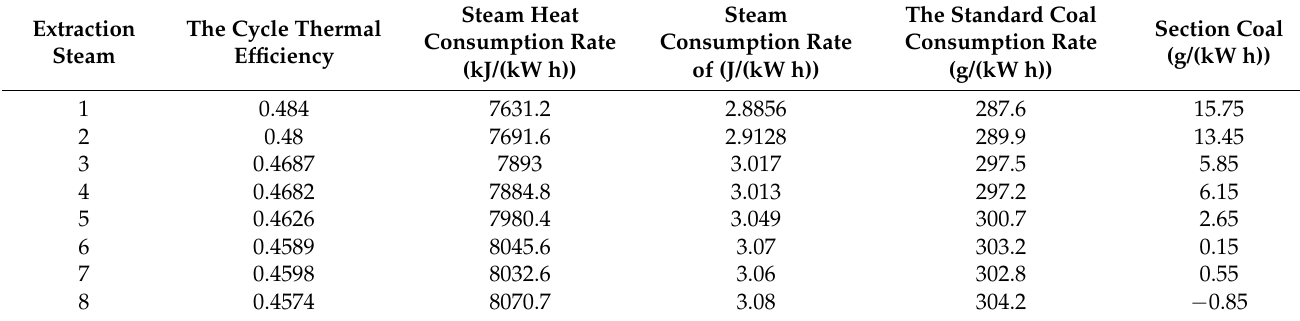
Table 5. Thermal economy of the SAPG system under partial variable conditions.